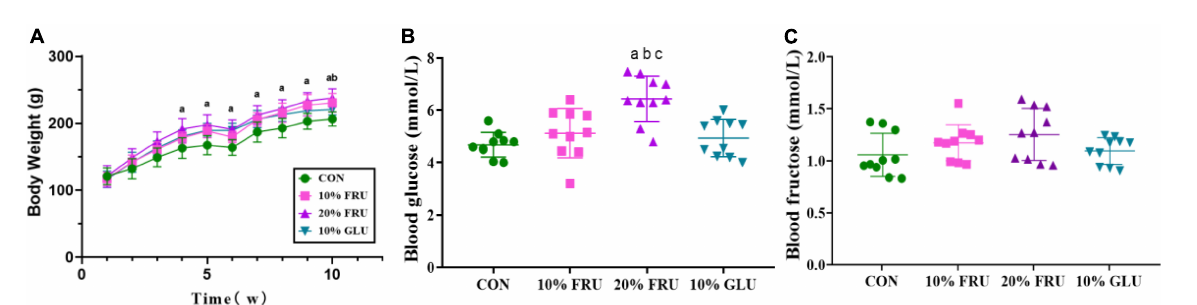
FIGURE1 Effects of excessive fructose intake on the physical and physiological parameters of rats: (A) body weight, (B) blood glucose, and (C) blood fructose after 10 weeks. The values were presented as mean ± SD ( n = 10); a means p < 0.05 compared with the CON group; b means p < 0.05 compared with the 10% GLU group; and c means p < 0.05 compared with the 10% FRU group.